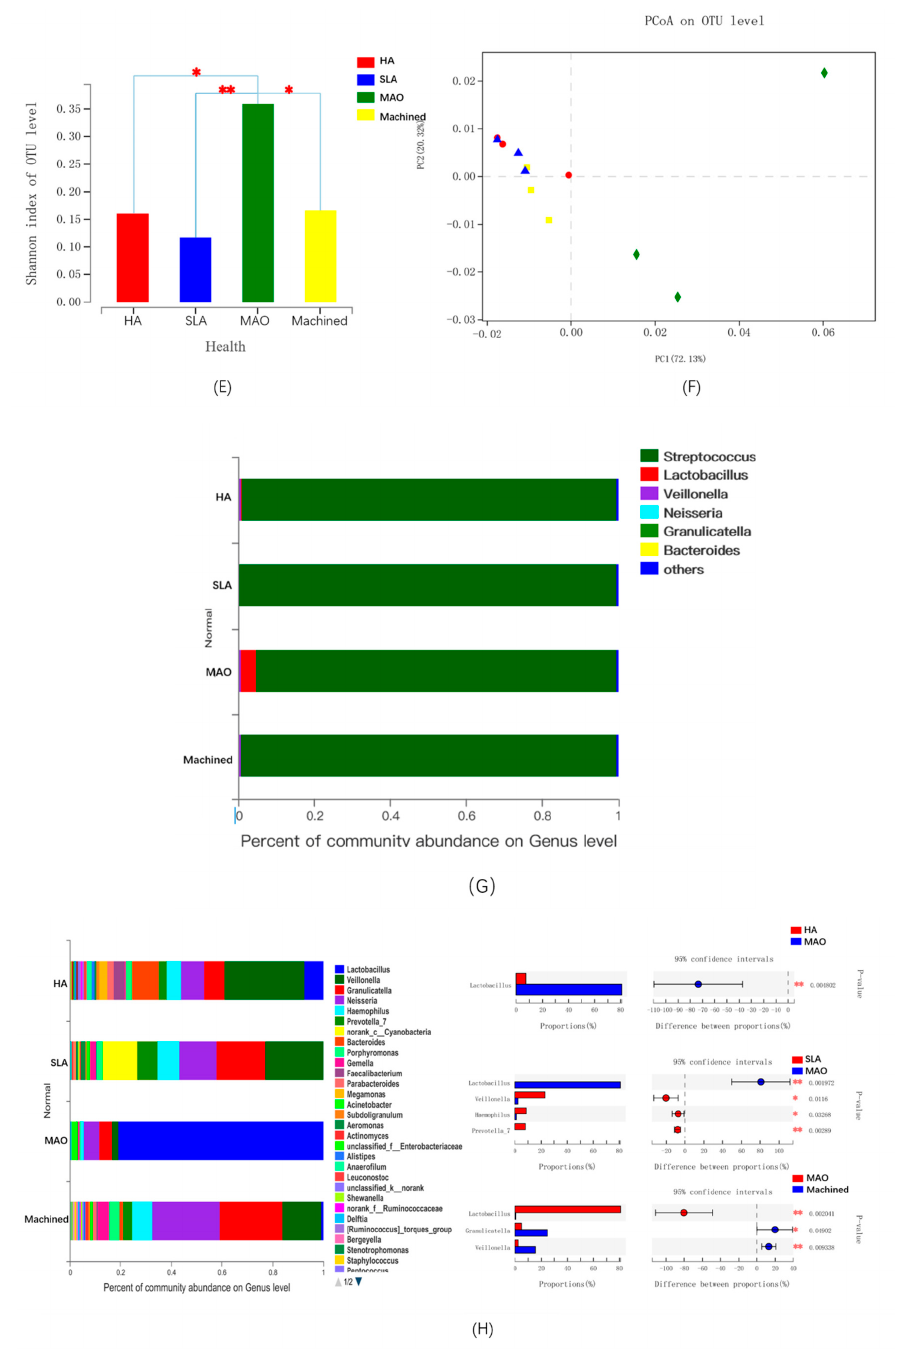
Figure 5. The microbial community of saliva-derived biofilms. ( A ) The alpha diversity of groups in the periodontitis group was measured using the Shannon index; ( B ) a principal co-ordinates analysis (PCoA) score plot of the HA (red), SLA (blue), MAO (green), and machined group (yellow) in the periodontitis group; ( C ) shows the percent of community abundance at the genus level in the periodontitis group; ( D ) Shows the percent of community abundance at the genus level after removing Streptococcus , and the comparison of two samples in the periodontitis group; ( E ) the alpha diversity of groups in the healthy group was measured using the Shannon index; ( F ) a principal co-ordinates analysis (PCoA) score plot of the HA (red), SLA (blue), MAO (green), and machined group (yellow) in the healthy group; ( G ) shows the percent of community abundance at the genus level after removing the Streptococcus from the healthy group; and ( H ) shows the percent of community abundance at the genus level and the comparison of two samples in the healthy